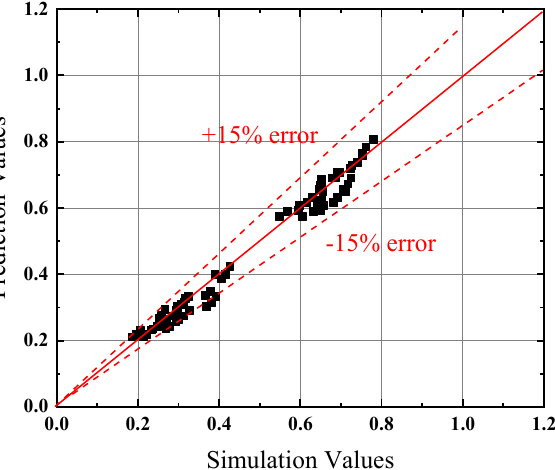
Figure 13. Comparison of dimensionless inlet air velocity values with the predictions by Equation (20).